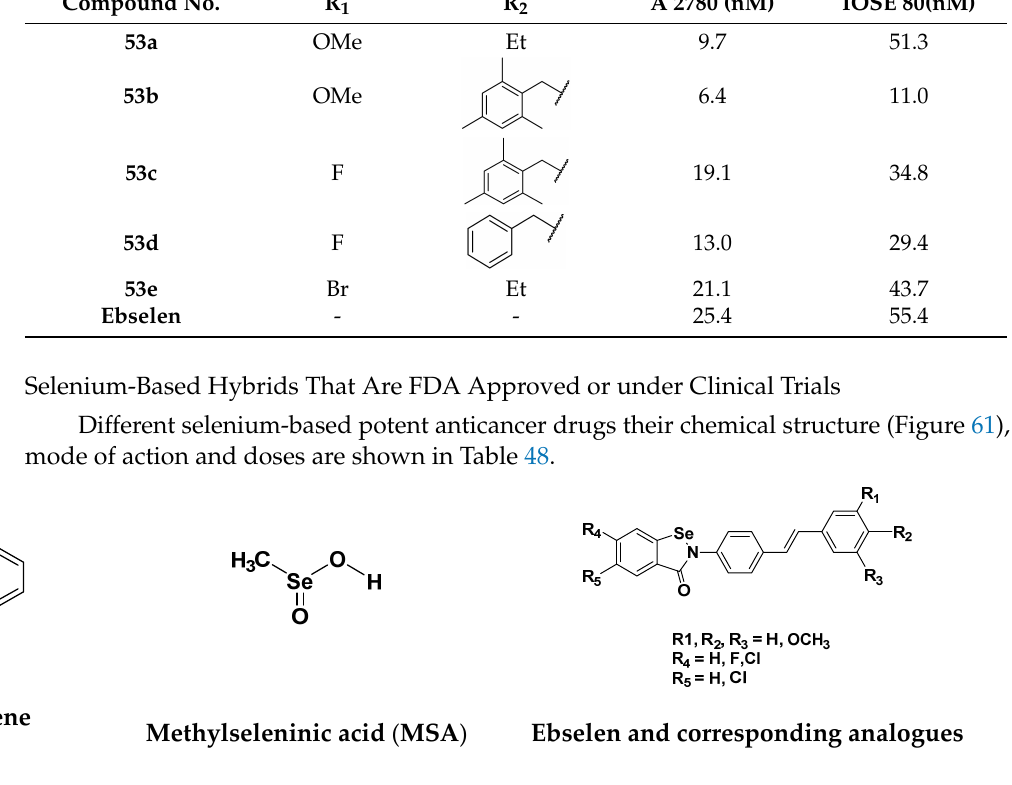
Figure 61. Selenium based potent anticancer compounds. Table 48. Selenium-based potent compounds with mode of action, specific cancer types and doses.